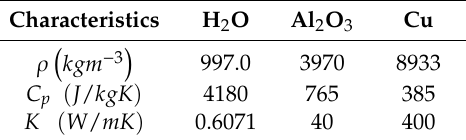
Table 2. Thermo-physical